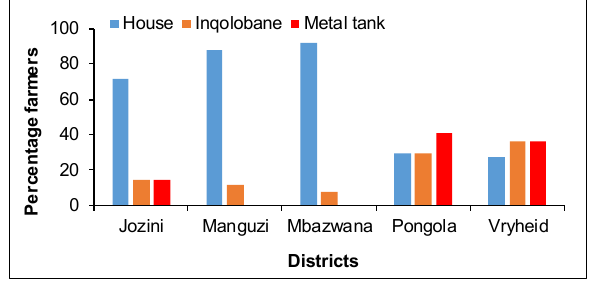
Figure 7: Storage facilities utilised by subsistence farmers in five districts of northern KwaZulu-Natal (chi-square: d.f.=8; p =0.0014). Consumption and trading of grain Farmers from all districts either only consumed or both consumed and sold their homegrown maize (Figure 8). Consumption with trading of homegrown maize and maize-farming districts were independent ( p =0.1766). Half the farmers in Mbazwana only consumed their homegrown groundnuts and the other half both sold and consumed their homegrown groundnuts. Over 60% of farmers in Jozini and Manguzi only consumed their homegrown groundnuts (data not shown). Consumption with trading of homegrown groundnuts and groundnut-farming districts were also independent ( p =0.635) (data not shown). All the farmers in Jozini and Manguzi only sold their homegrown maize to the local community; farmers in Mbazwana, Pongola and Vryheid also sold their homegrown maize to the nearest markets (data not shown). Maize trading areas and maize districts were dependent on each other ( p =0.0046) (data not shown).